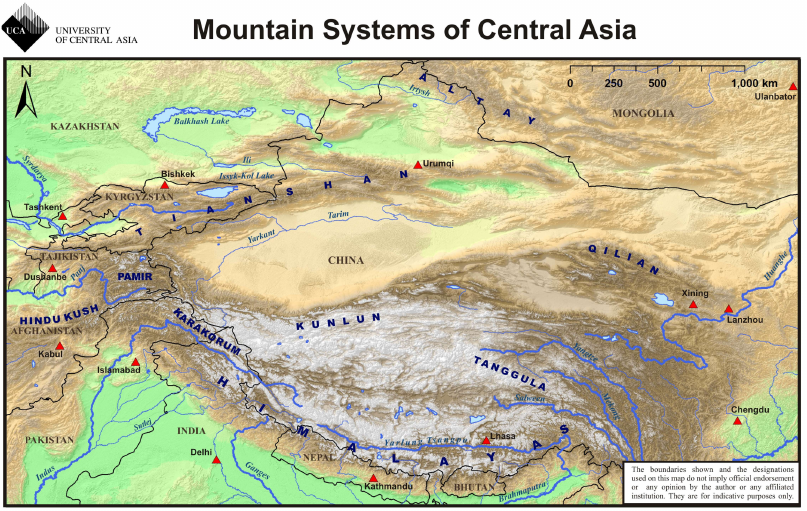
Figure 2. The mountains of western China and Central Asia (Mountain Societies Research Institute, University of Central